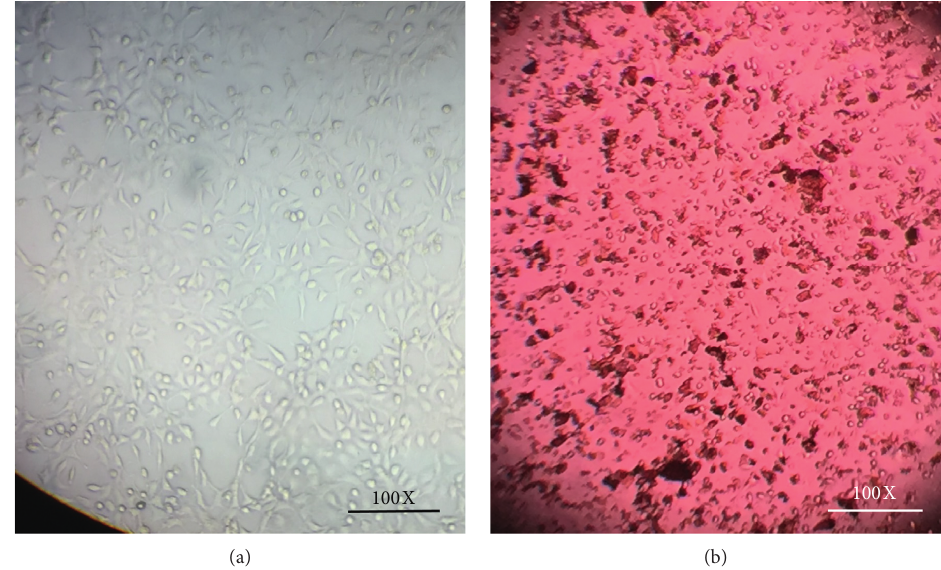
Figure 7: Optical microscopy of (a) untreated Hep-G2 cells and (b) Hep-G2 cells treated with 50 μ g/mL GO/Fe